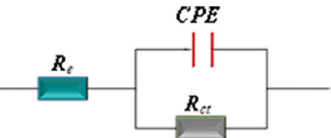
Figure 5. Model of the electrical equivalent circuit used to fit EIS data. From the diagram, it can be seen that the phase angle has a value of about − 70° when the inhibitor is added. This finding provides an opportunity to insert an element with a constant phase angle (CPE) into the equivalent circuit. The solution resistance R e , the charge transfer resistance R ct , the element with a constant phase angle CPE, and the inhi ‐ bition effect η is determined and summarized in Table 2. The CPE is related to the double ‐ layer capacitance C dl . The non ‐ ideal dielectric behavior of the inhomogeneous metal sur ‐ face led to the use of the CPE instead of a pure capacitor. CPE describes various physical